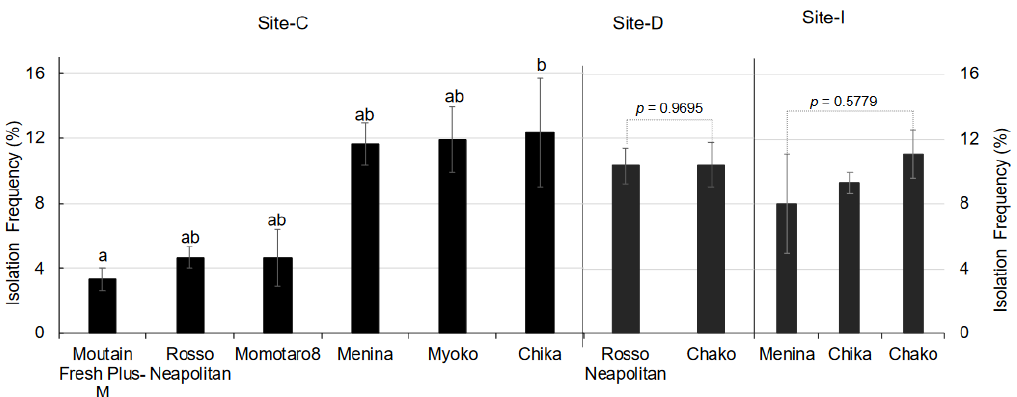
Figure 2. Isolation frequency (IF) of fungal endophytes from the stem of nature farming tomato ( Solanum lycopersicum ) at three di ff erent locations in Japan. The IF refers to the mean number of taxa isolated from a cultivar and expressed as percentage (%) of tissue plated in PDA plates. The error bar indicates the standard error (SE) of the mean. The p -values were obtained from ANOVA (Site-D and Site-I) and by post hoc test using Tukey’s HSD test (Site-C) to indicate significant di ff erences (di ff erent letters above the